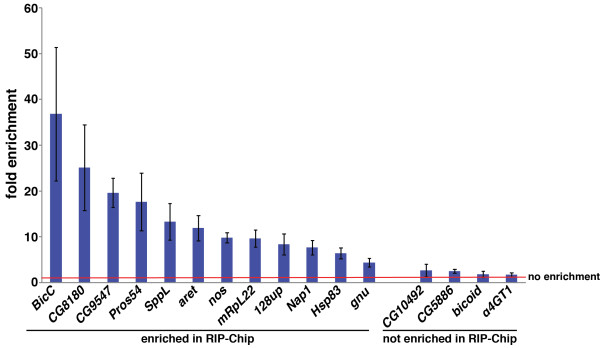
Validation of Smaug-bound mRNAs. The fold enrichment of mRNAs in Smaug RIPs versus control RIPs was determined via RT-qPCR and normalized to the levels of RpL32 mRNA in the immunoprecipitated material. The red line indicates one-fold (that is, no) enrichment. Results are the average of three independent experiments and error bars indicate standard error of the mean.